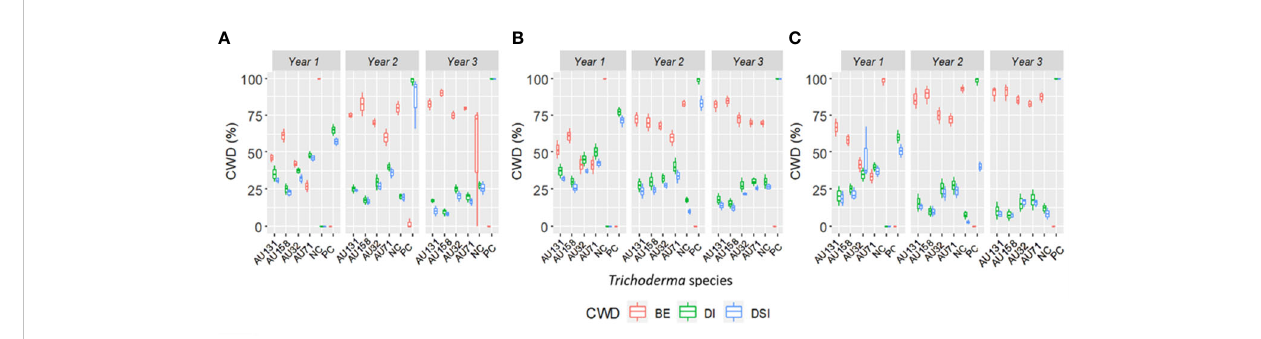
FIGURE 9 Boxplots representing the annual distribution of CWD for three consecutive years. (A) Teppi fi eld site, (B) Gera fi eld site and (C) Jimma fi eld site. Trichoderma isolates: T. longibrachiatum AU32, T. asperellum AU71, T. asperellum AU131, T. longibrachiatum AU158. PC, Positive Control; NC, Negative Control; CWD, Coffee Wilt Disease; BE, Biocontrol Ef fi cacy; DI, Disease Incidence and DSI, Disease Severity Index. Year 1 = 2018/19, Year 2 = 2019/20 and Year 3 = 2020/21. The boundaries of the boxplots indicate the 25 th and 75 th percentiles, and the solid line within the boxes indicates the median